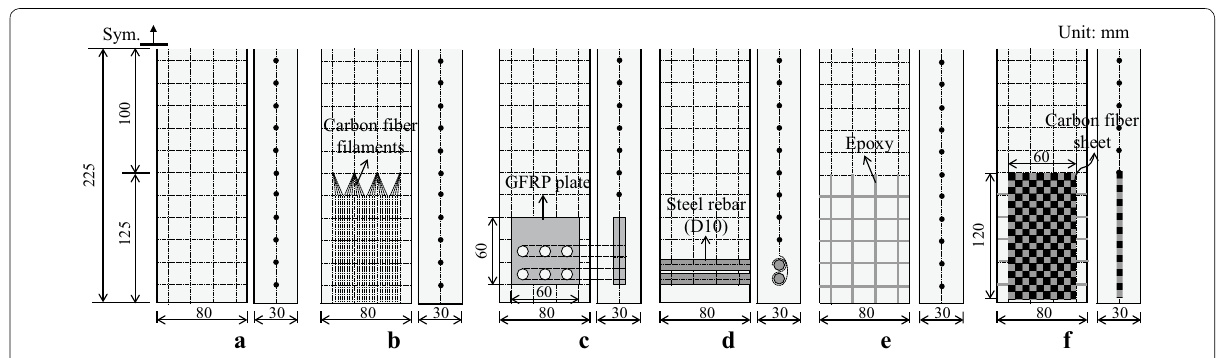
Fig. 3 Details of anchorage methods. a BASE, b SPREAD, c TAB, d REBAR, e L_COAT, f